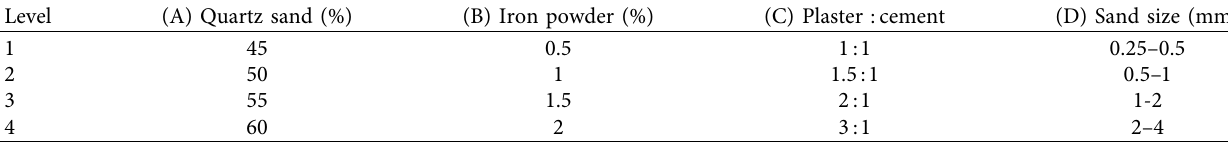
Table 2: Factor levels in orthogonal experimental design covered by the study.